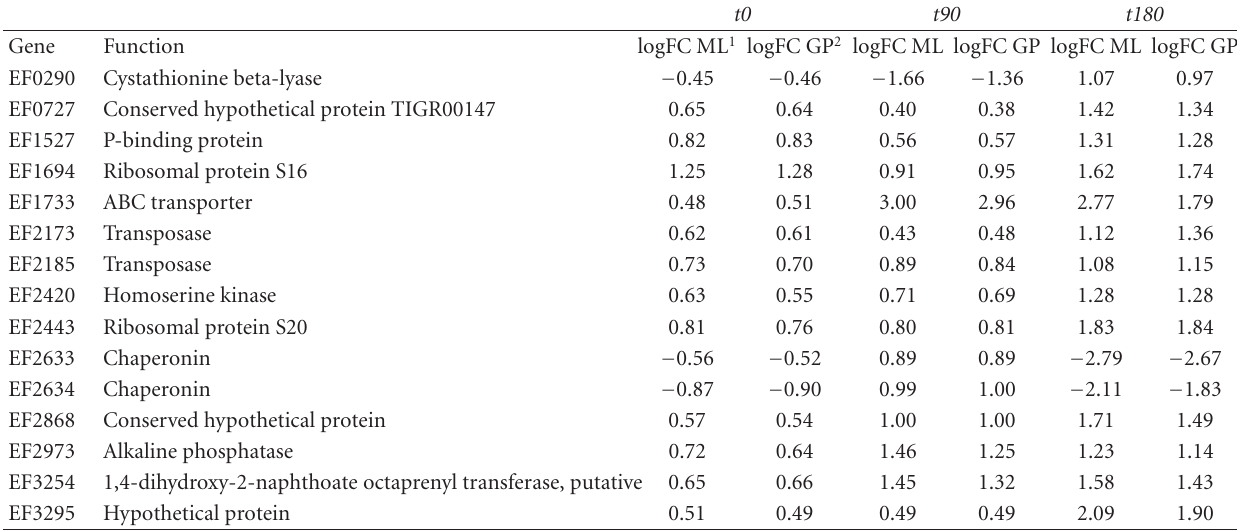
Table 1: Genes whose expression was significantly di ff erent from 0 (upregulated or downregulated during the whole time series (three time